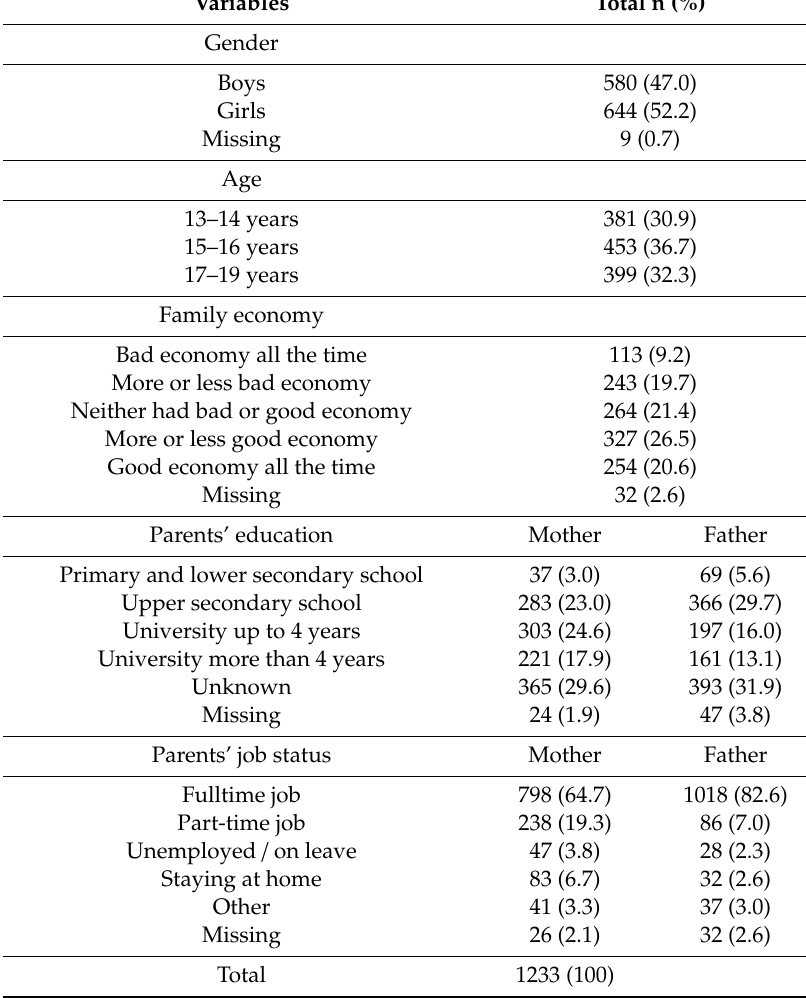
Table 1. Demographic characteristics of the